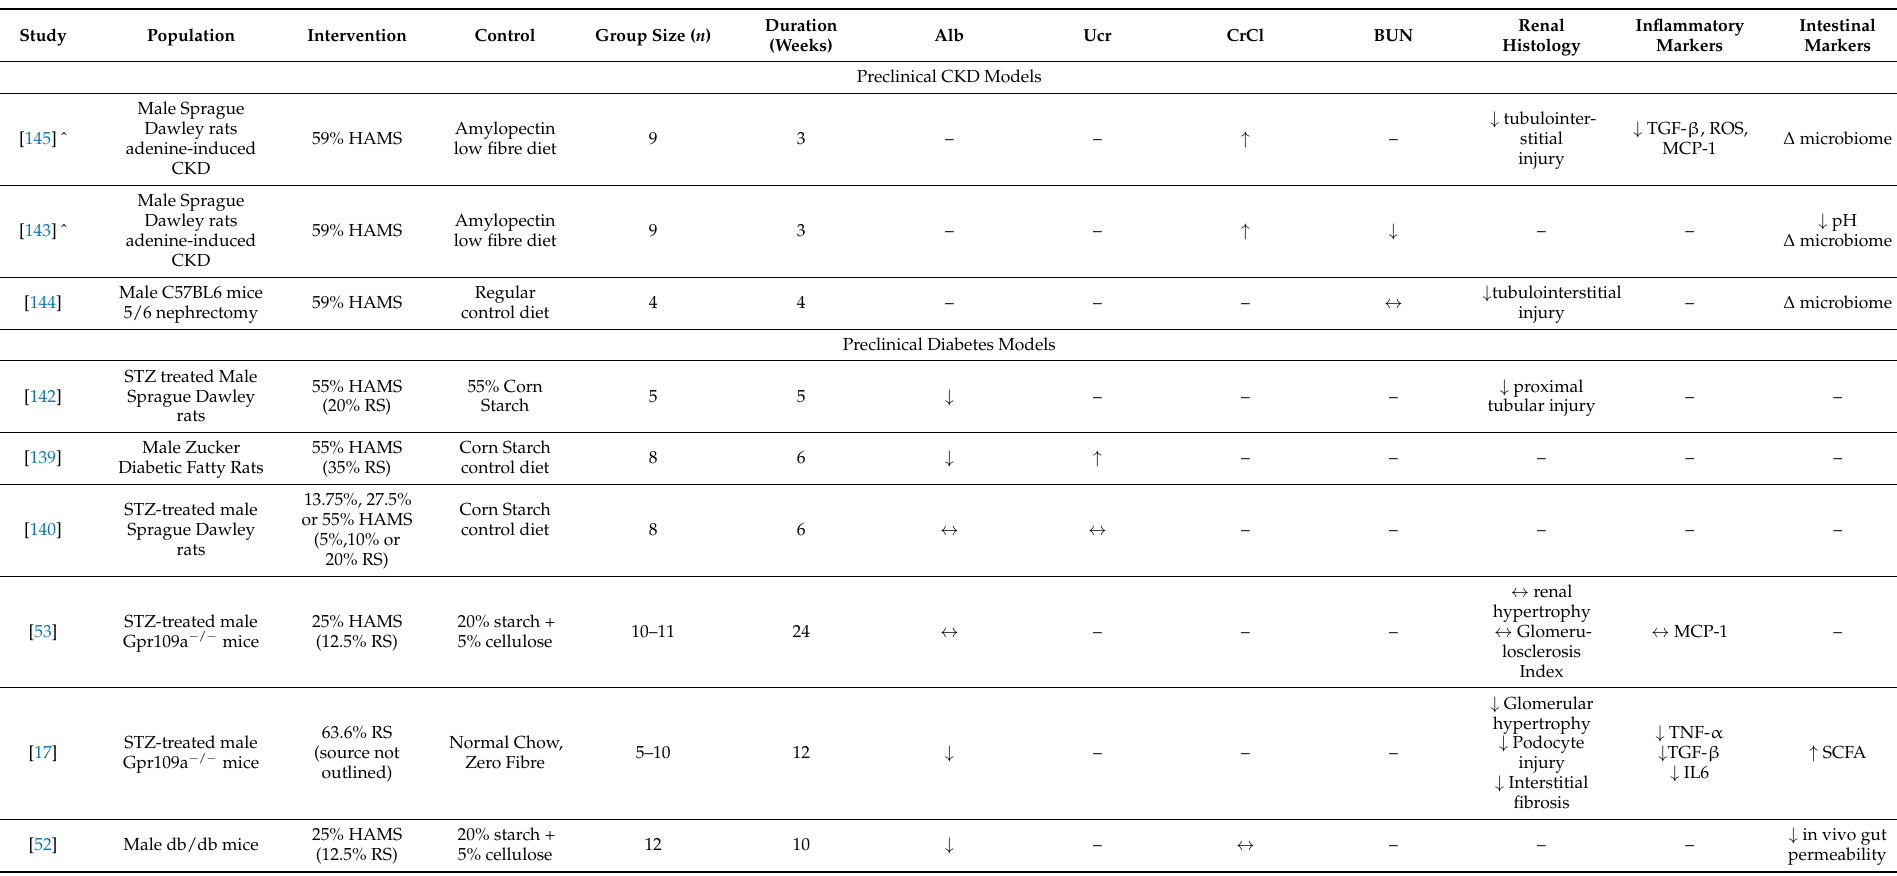
Table 2. Overview of Studies Investigating Resistant Starch in Animal Models of Chronic Kidney Disease and Diabetic Kidney